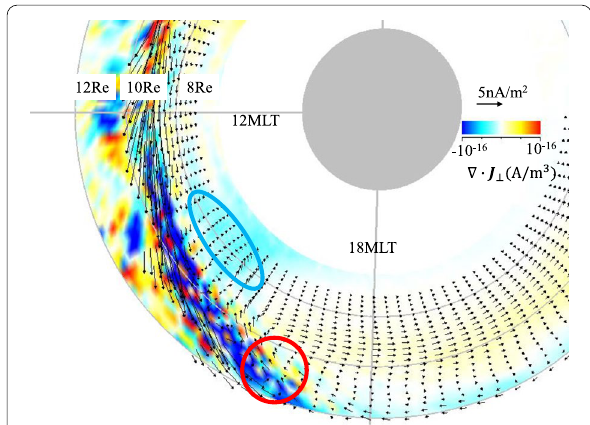
Fig. 6 FPC vectors in the post-noon sector of the equatorial plane at 5.5 min. ∇ ⊥ · J ⊥ values in the equatorial plane are shown with color shading. The red circle indicates the equatorial projection of the region where the cross-magnetopause current exists. The type L current flows across the magnetopause in this region. In contrast, the blue ellipse indicates the equatorial projection of the region where the type H current system converts from the FPC to the FAC. It is evident that the current exhibits negative divergence ( ∇ · J ⊥ < 0 ) in the blue